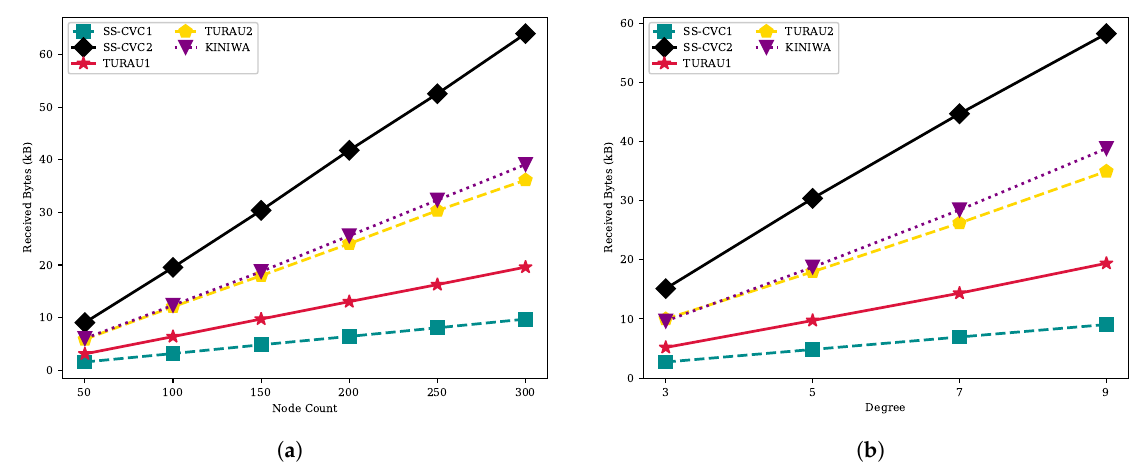
Figure 10. Received bytes of algorithms on weighted networks: ( a ) Received bytes against node count on the fixed average degree 5; ( b ) Received bytes against node count on the fixed network size 150.